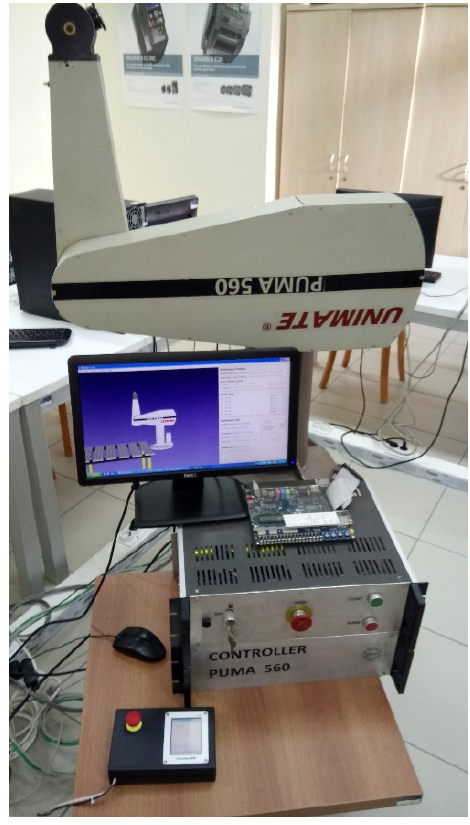
Figure 8. The robot with the controller, pendant and RoKiSim.